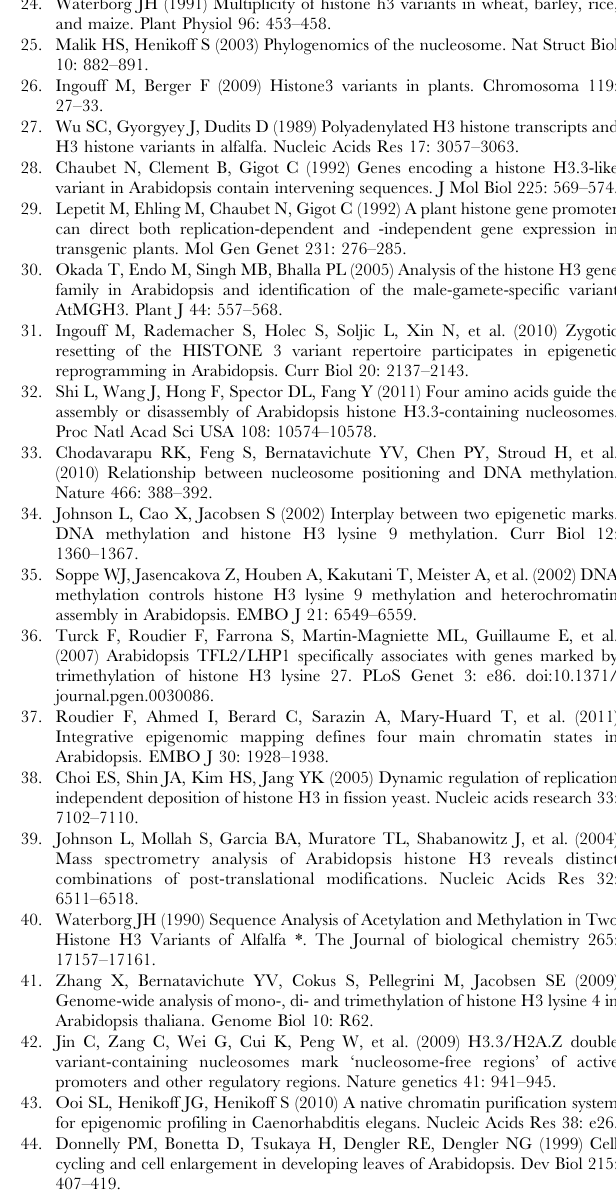
Table S1 Overview of sequencing libraries analyzed. (DOC) Table S2 Expression of the top-most cell-cycle dependent and independent genes in dividing and non-dividing tissue. CycleBase ranks were extracted from www.cyclebase.org with ranks from 1 to 20,945 reflecting the magnitude of cell-cycle dependent regulation. FPKM values are mean values obtained from the HTR5::GFP and HTR13::GFP mRNA-Seq libraries. Table S3 Tab-delimited file containing FPKM values for each TAIR9 annotation. The last column contains the information whether the gene was kept or not for the downstream analyses based on expression variation between replicates from the same tissue (see Materials and Methods).